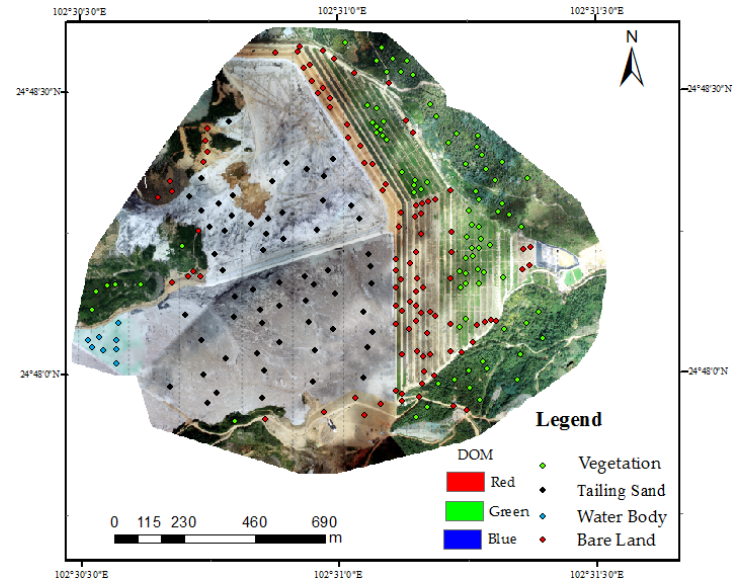
Figure 14. Sample point distribution.